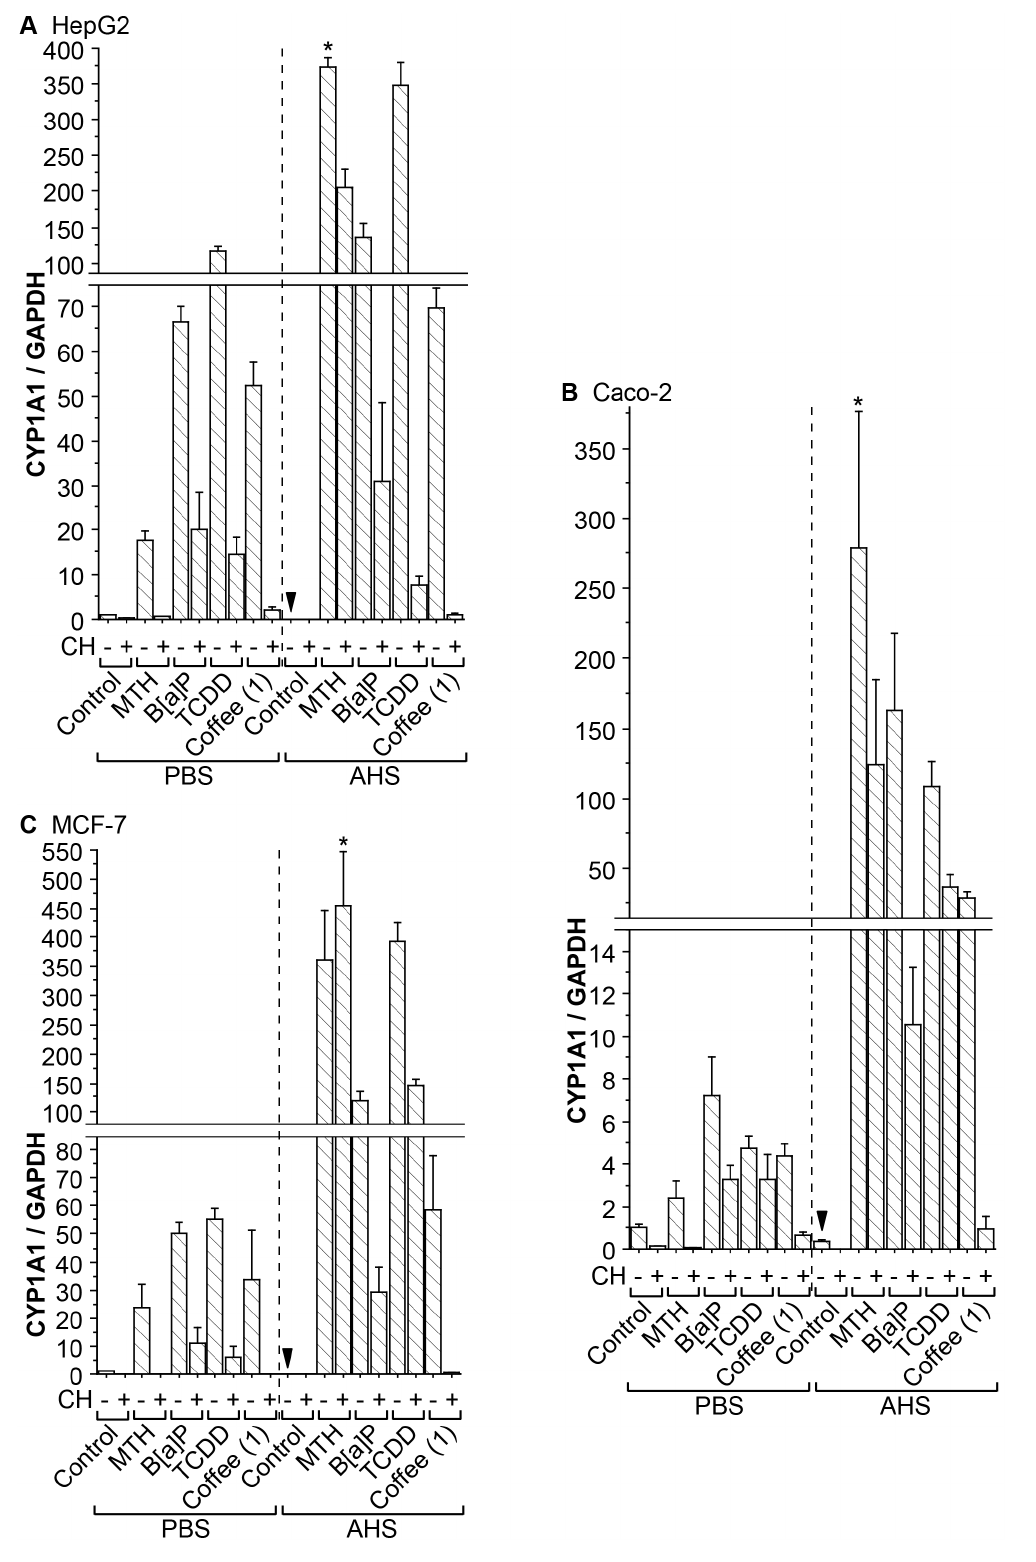
Figure 4. Induction of CYP1A1 mRNA by coffee. HepG2 ( A ), Caco-2 ( B ), and MCF-7 ( C ) cells were incubated for 4 h in either PBS or AHS with each sample added as in Fig. 3, except that TCDD was added only at 10 2 6 M. Error bars indicate SDs for triplicate samples. The mean values for the control cells treated with DMSO in PBS were defined as 1.0. Asterisks indicate statistically significant differences ( p , 0.05) from the control cells incubated in AHS (arrowheads).